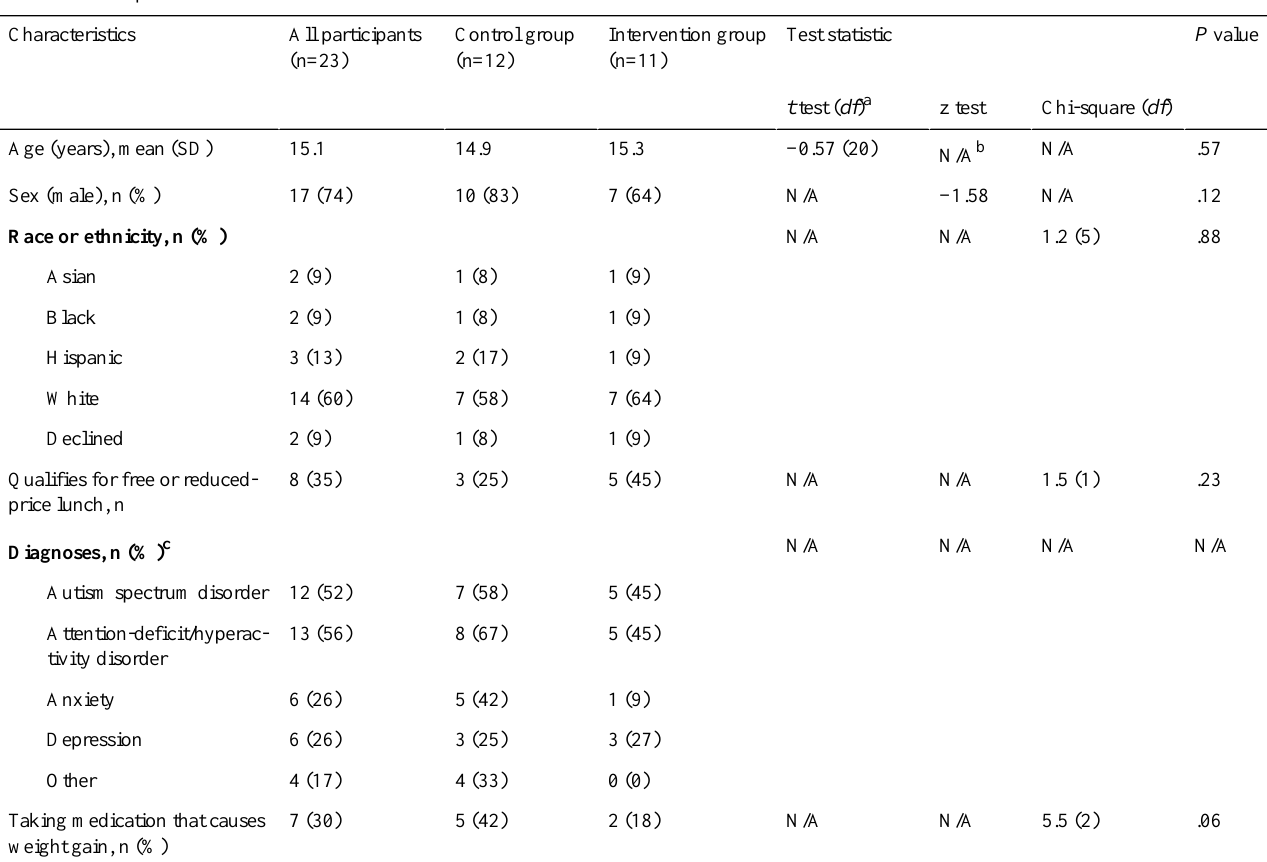
Table 1. Participant characteristics at